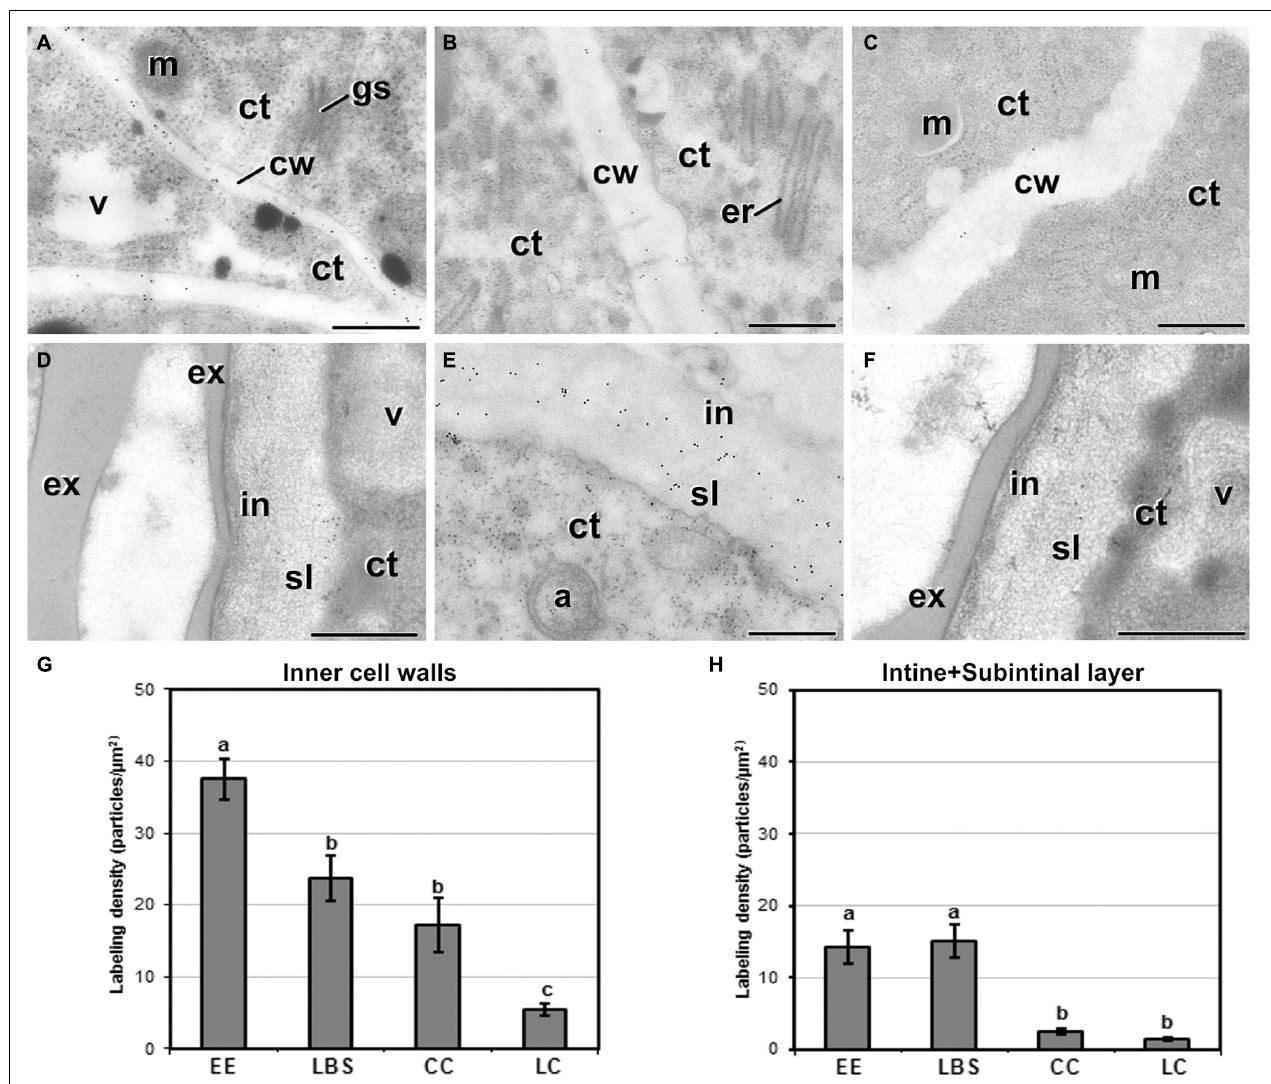
FIGURE 4 | Callose detection by immunogold labeling and quantification in TEM images of 5-day-old microspore cultures. Inner cell wall images from EE (A) , LBS (B) , and LC (C) structures. Outer cell wall images from EE (D) , LBS (E) , and CC (F) structures. (G) Callose labeling density in inner cell walls. (H) Callose labeling density in external cell walls. Different letters represent significant differences according to the LSD test. Labeling density is expressed in number of particles per µ m 2 . a, autophagosome; ct, cytoplasm; cw, cell wall; er, endoplasmic reticulum; ex, exine; gs, Golgi stack; in, intine; m, mitochondrion; v, vacuole. Bars: 500